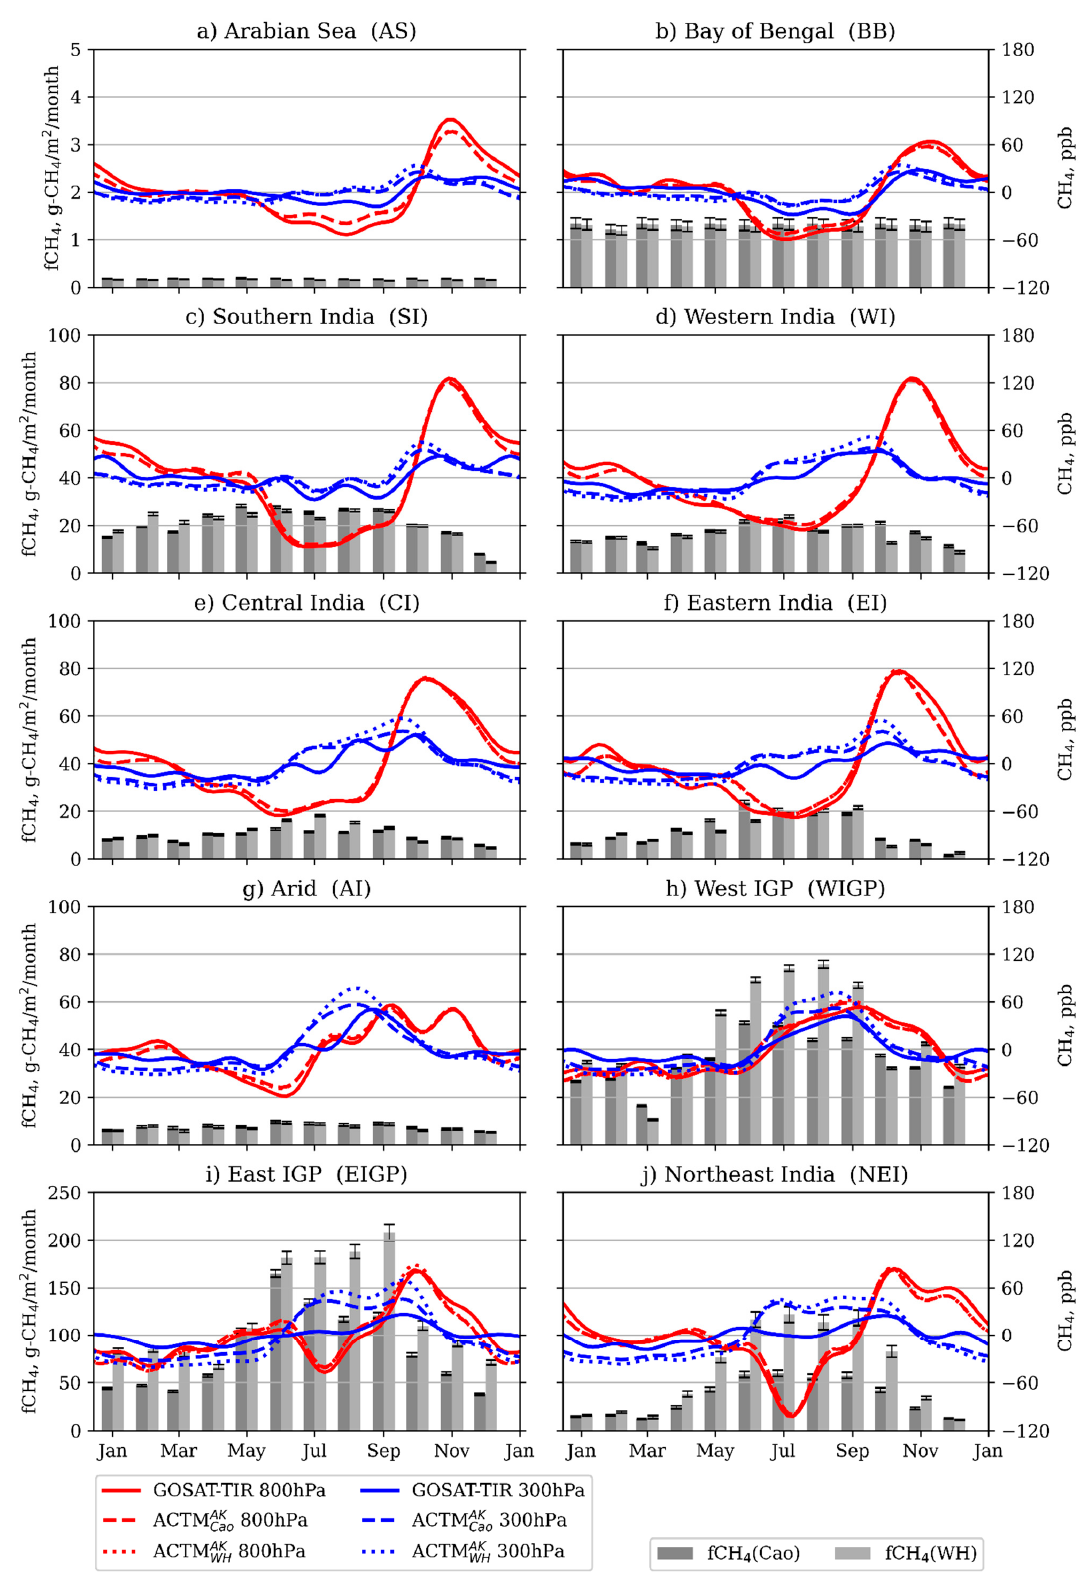
Figure 11. Multi-year (2009–2014) seasonal variation of CH 4 (right y -axis) derived by implementation of the Prophet model for levels of 800 (red lines) and 300 hPa (blue lines) over considered regions from GOSAT-TIR (solid line), ACTM AK line), and ACTM AK (dotted line), respectively. At the background, bar plots represent Cao (dark grey) and WH (light grey) WH CH 4 fluxes (left y -axis), respectively. Please note the different scale of y -axes (left) for